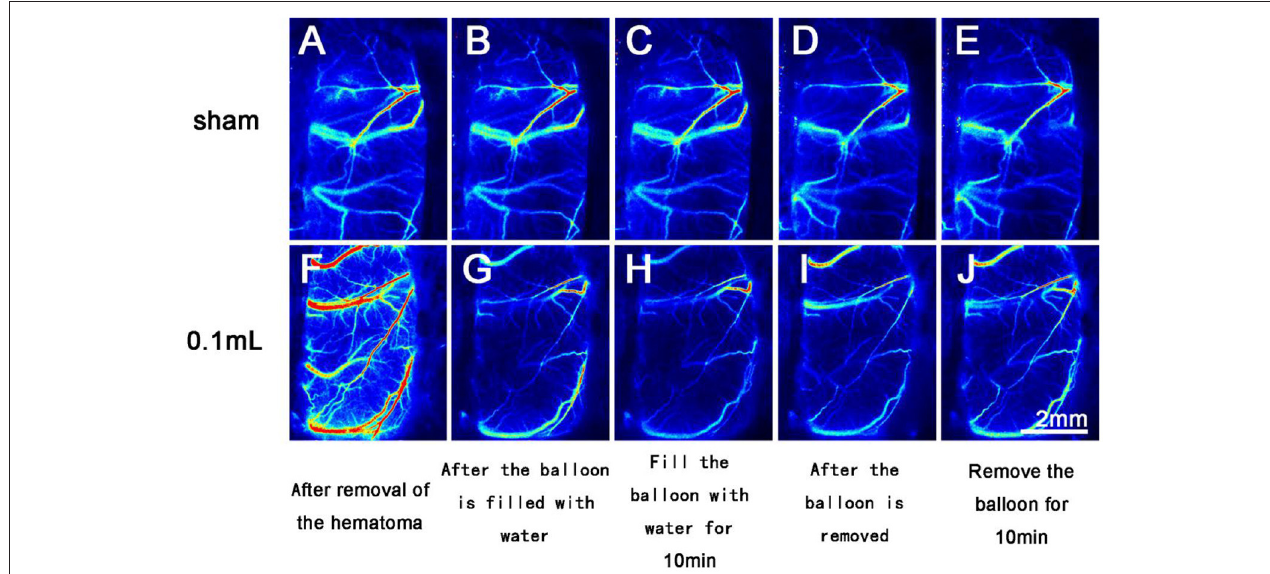
FIGURE 5 | Laser speckle imaging of cerebral arterial and venous blood flow on the side with the brain bulge. (A–E) The cerebral surface blood flow of rats in the Sham group remained basically unchanged throughout the 40min after hematoma removal. (F–J) The cerebral surface blood flow of rats in the 0.1ml group decreased significantly after balloon filling and brain tissue swelling but gradually recovered after balloon removal.